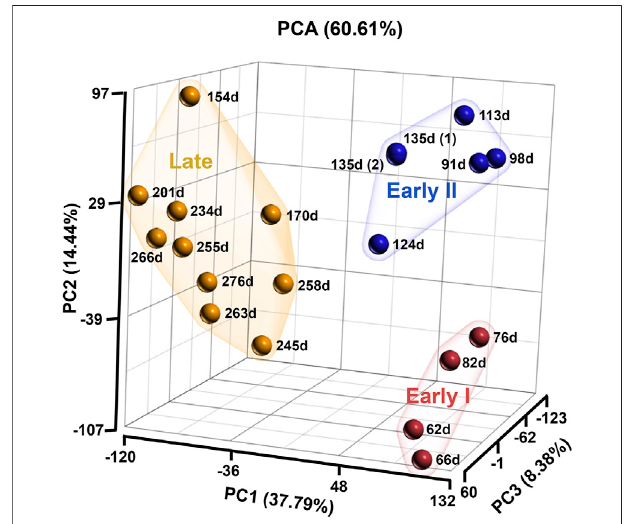
FIGURE 1 | Principal Component analysis of bovine ovarian samples analysedin theRNAsequencing. Thesamplesare groupingintothree stages; early I (red; 62 – 82 days, n (cid:1) 4), early II (blue; 91 – 135 days, n (cid:1) 5) and late (orange; 154 – 276 days, n (cid:1)